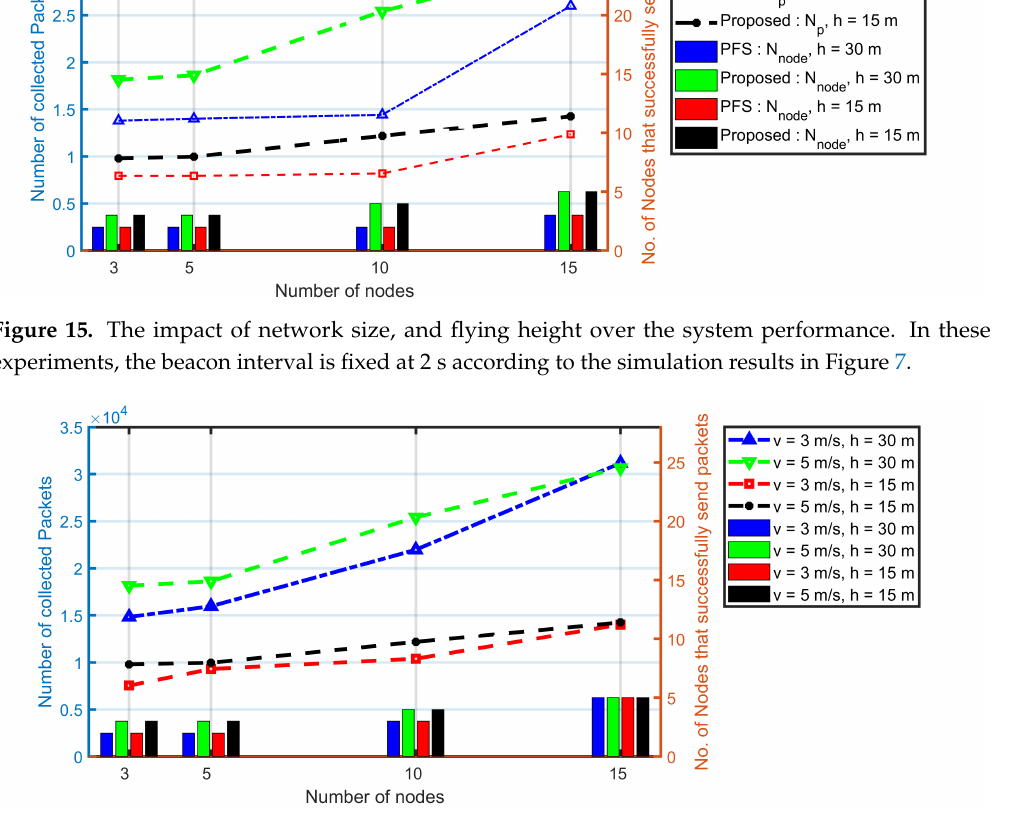
Figure 16. The impact of network size, and UAV’s speed over the system performance. In these experiments, the beacon interval is fixed at 2 s. All the results are based on the combination of Balance and PCdFS